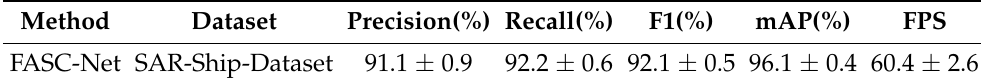
Table 4. Experimental results on the